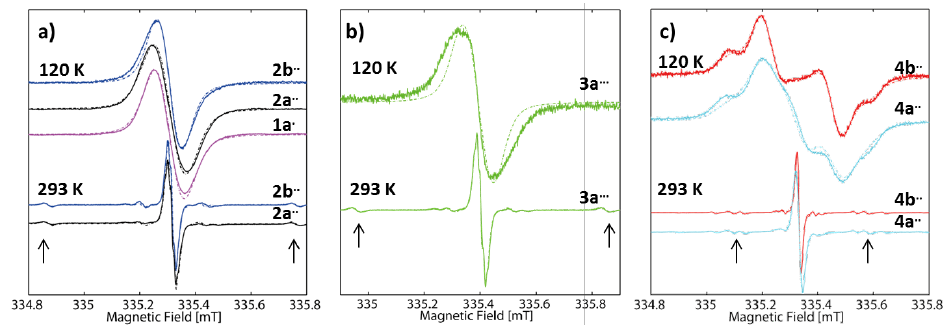
Figure 4. CW EPR spectra of: ( a ) 2a •• and 2b •• ; ( b ) 3a ••• ; and ( c ) 4a •• and 4b •• (full lines) in degassed CD 2 Cl 2 /MeOD (2:1) at 293 K and 120 K using an extended magnetic field axis. The color code is the same as in Figure 3. The dashed lines are simulations of the spectra obtained using EasySpin [60]. The arrows indicate the position of the satellite caused by the o - 13 C nuclei. In ( a ), the frozen solution spectrum of monotrityl 1a • is given as reference spectrum.